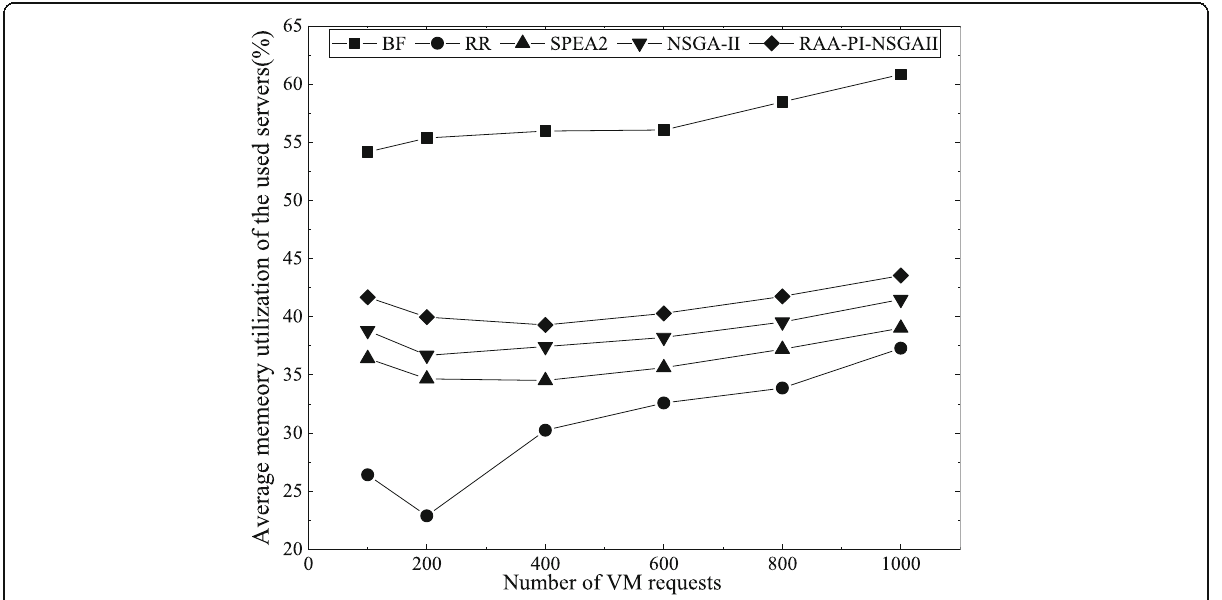
Fig. 8 Average memory utilization of the used physical